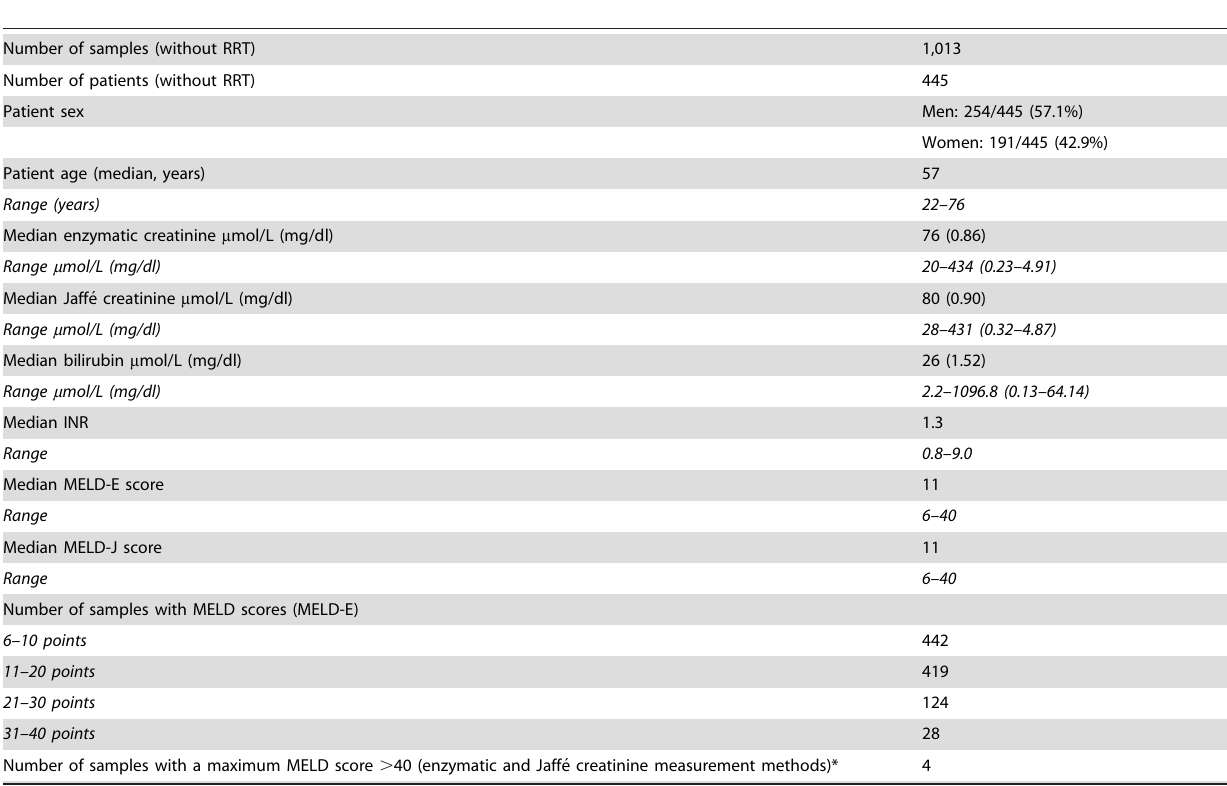
Table 1. The baseline characteristics of the patients and samples in the study.